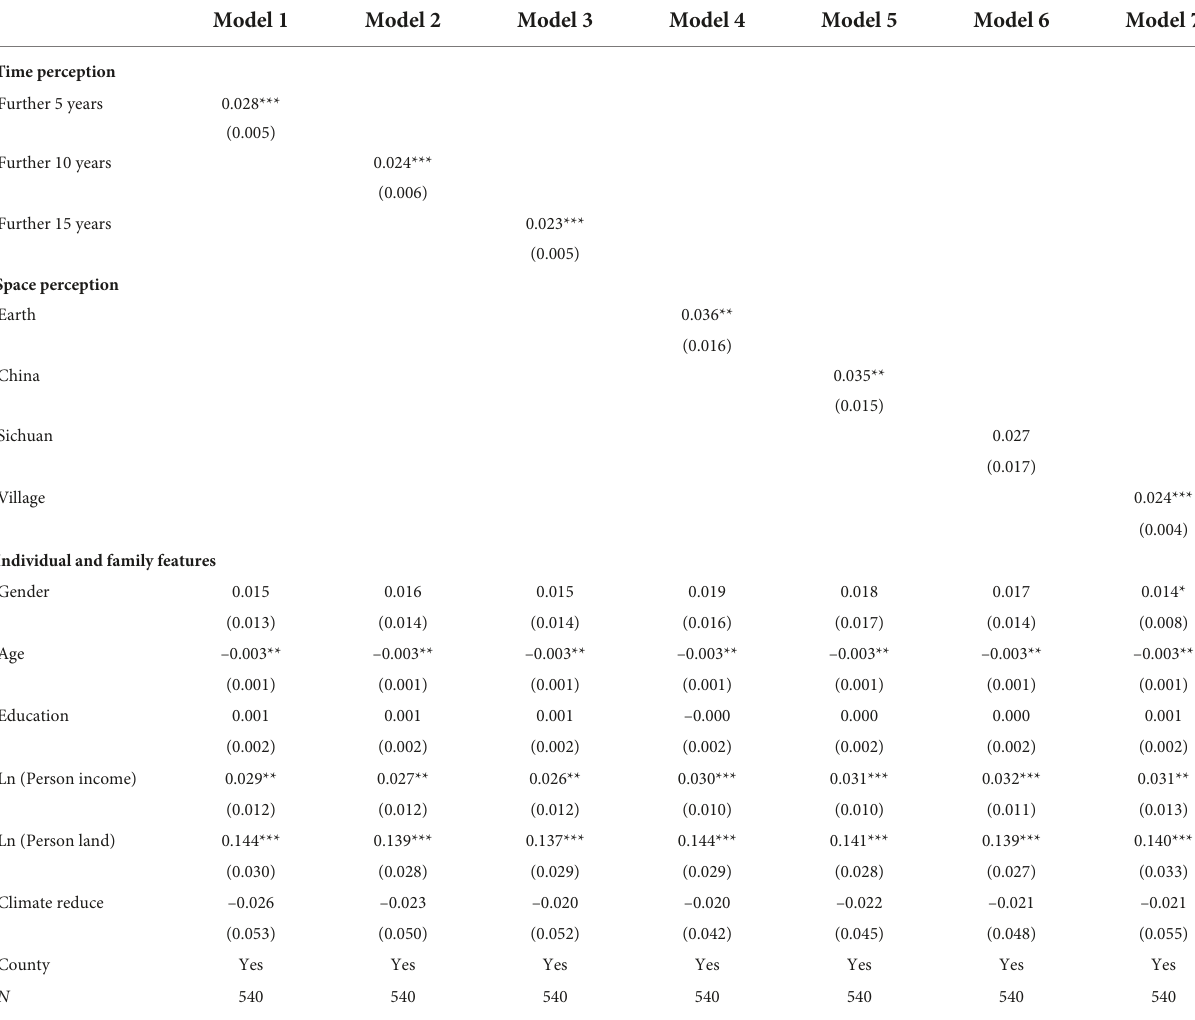
TABLE 2 Logit regression results of climate change time and space perception of